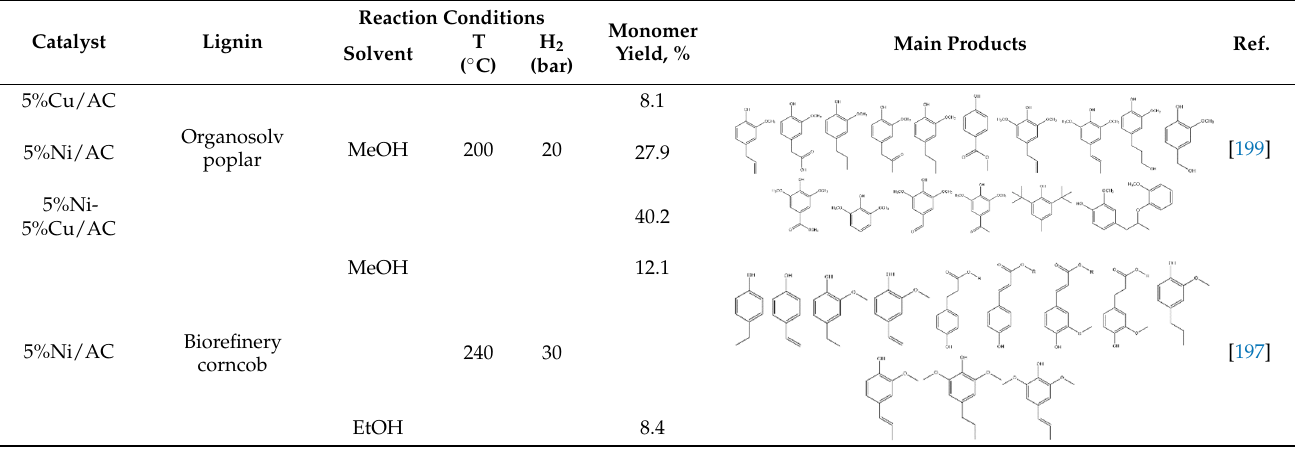
Table 3. Lignin hydrogenolysis over metallic catalysts supported on activated carbons.